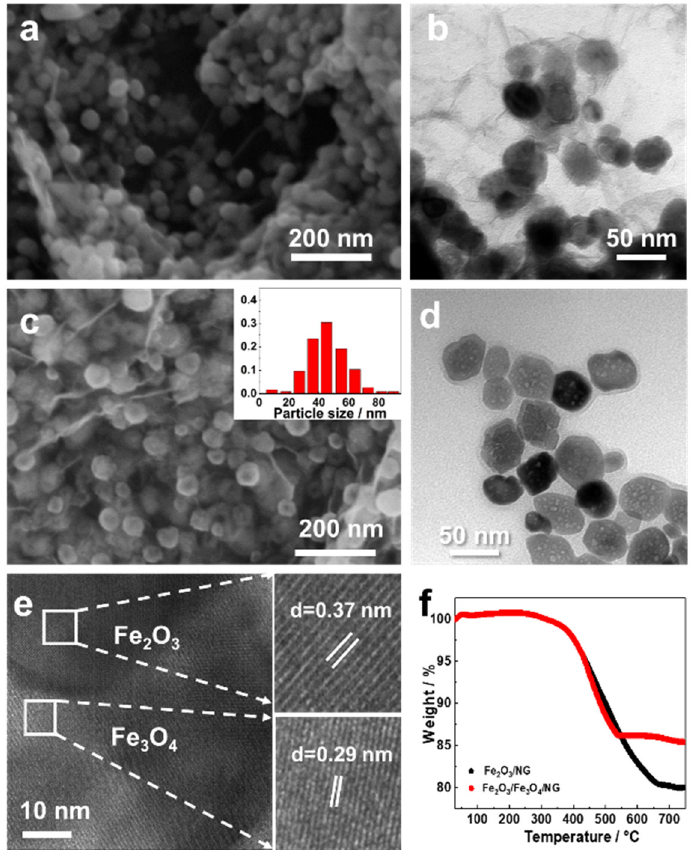
Figure 1. ( a , b ) SEM, TEM images of Fe 2 O 3 / NG composites. ( c , d ) SEM, TEM images of Fe 2 O 3 / Fe 3 O 4 / NG composites. The inset shows particle size distribution of Fe 2 O 3 / Fe 3 O 4 . ( e ) An HRTEM image of a Fe 2 O 3 / Fe 3 O 4 particle, the right two panels denote interplane spacings of Fe 2 O 3 and Fe 3 O 4 . ( f ) TGA curves of Fe 2 O 3 / NG and Fe 2 O 3 / Fe 3 O 4 / NG composites.